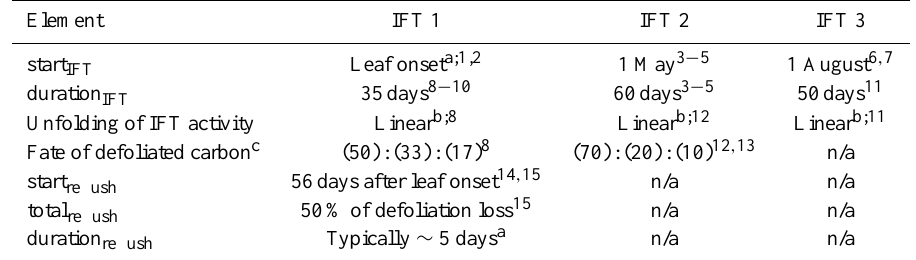
Table 1. Parameters for the insect functional types (IFTs) currently represented in MIM (see Eqs. 1–2 for start IFT , duration IFT , start reflush , total reflush , and duration reflush ); n/a: not